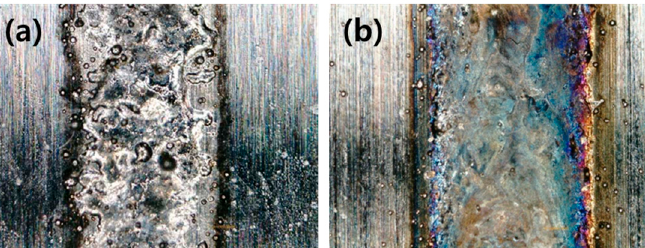
Figure 11. Single-tracks of different conditions between ( a ) incomplete single-track and ( b ) good single-track [97].